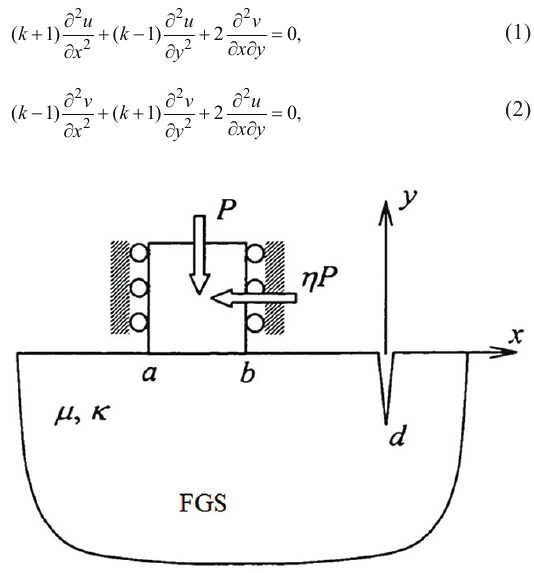
Figure 1. FGS half-plane containing surface crack in frictional sliding contact with a rigid punch of an flat